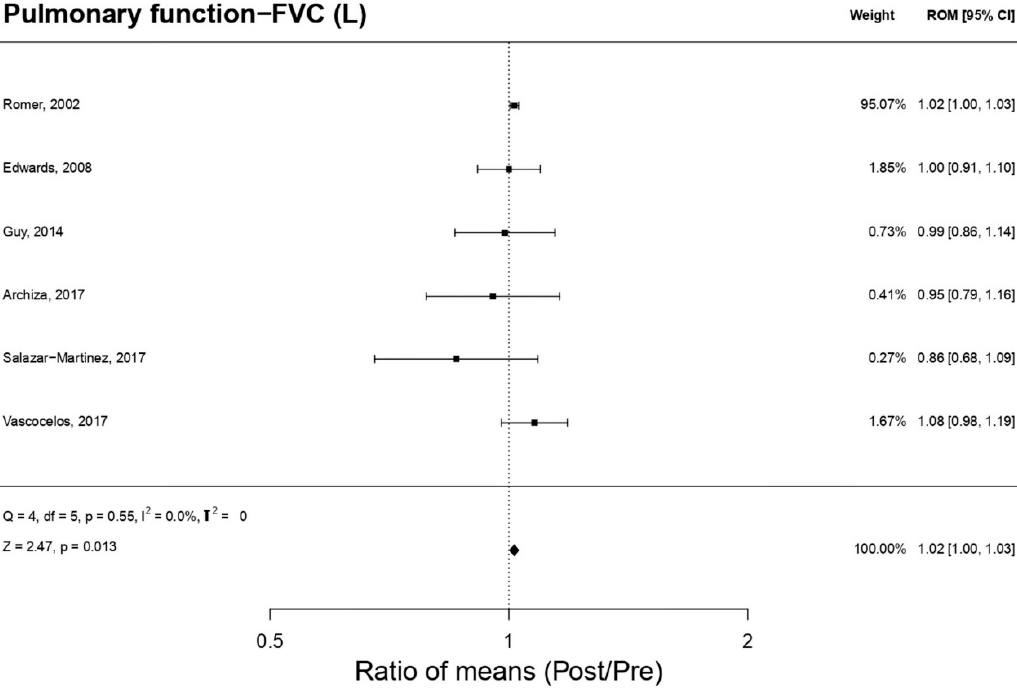
Figure 4. Forest Plot meta-analysis results for Force Vital Capacity.